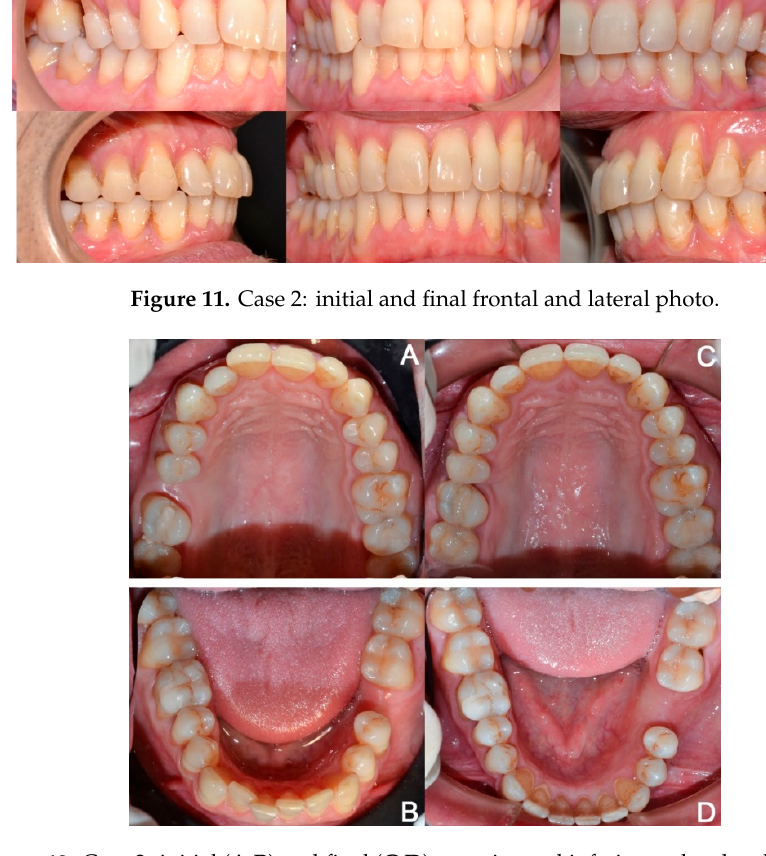
Figure 12. Case 2: initial ( A , B ) and final ( C , D ) superior and inferior occlusal arches photos.